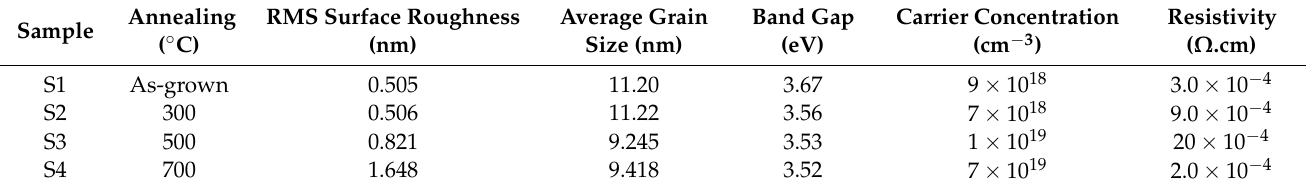
Table 1. Root mean square (RMS) surface roughness, average grain size as measured by AFM images, optical, and electrical properties of TiN films.